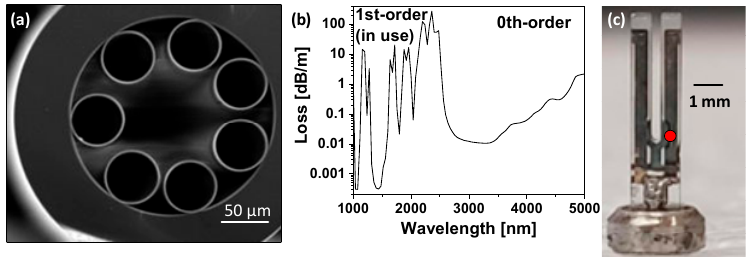
Figure 1. ( a ) SEM image of the used ARHCF. ( b ) ARHCF’s loss characteristic. ( c ) Photograph of the implemented QTF. The red dot marks the optimal heating area.